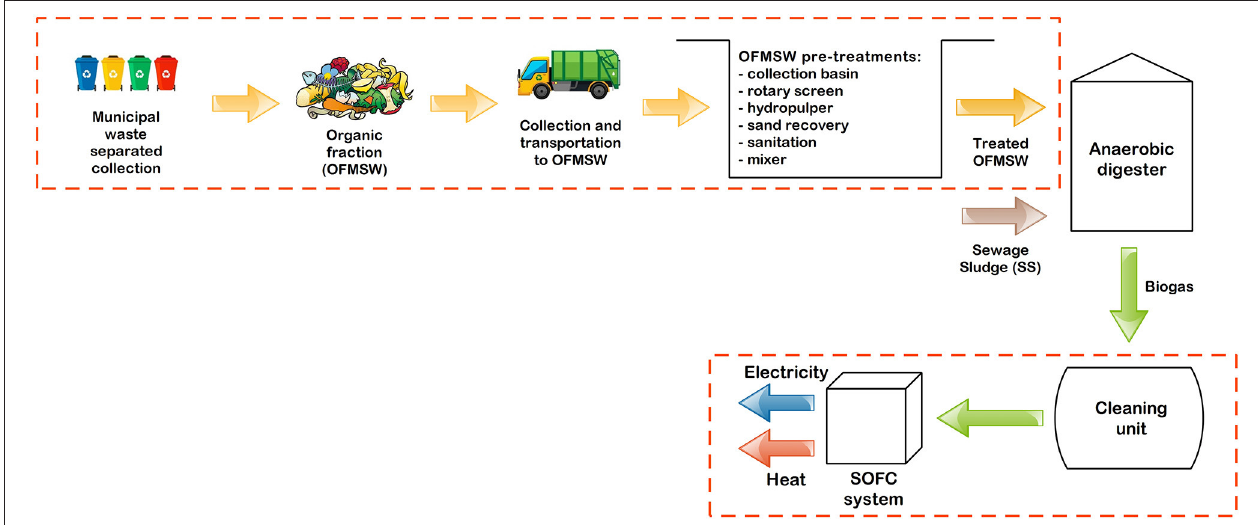
FIGURE 6 | Proposed WWTP retrofitting for reaching energy self-sufficiency. Proposed actions are in red dashed boxes.